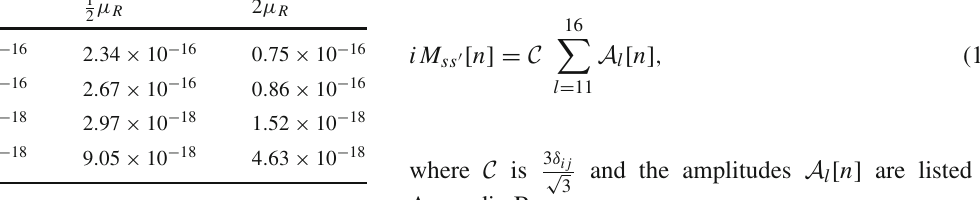
R μ = 2 m R b for